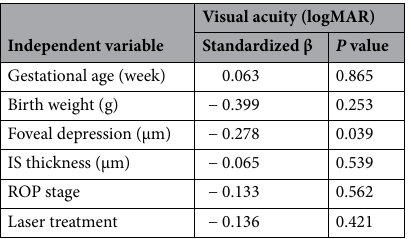
Foveal depression